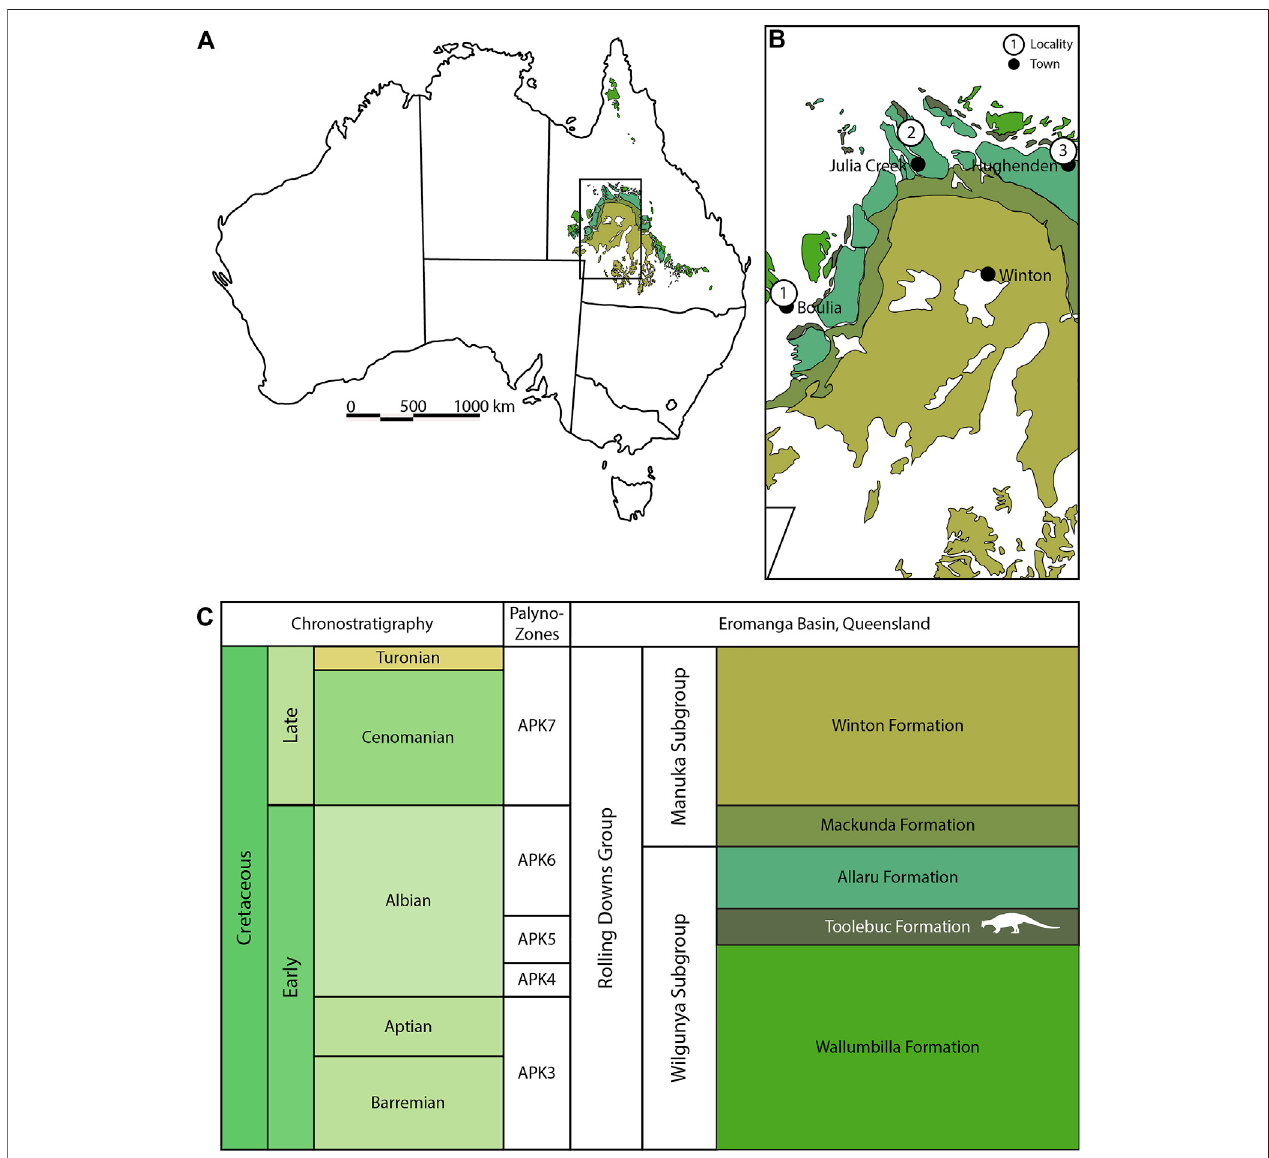
FIGURE 1 | Spatiotemporal context of the Eromanga Basin, Queensland, Australia. (A) Map of Australia with Eromanga Basin formations highlighted, based on Pentland and Poropat (2019). (B) Toolebuc Formation ankylosaur localities.1 — SAMA P40536 location, near Boulia (this study); 2 — QM F33286 location, near Julia Creek;3 — AMF35259andAMF119849location,nearHughenden.AnkylosaurlocationsbasedonLeaheyetal.(2015). (C) ChronostratigraphyoftheEromangaBasin, highlighting themid-Albian ToolebucFormation (in white). Formation colorsmatch (A) and (B) ,basedon Cavin and Berrell (2019).Ankylosaur silhouette generated by Jagged Fang Designs and reused under Creative Commons licenses: Public Domain Dedication 1.0.